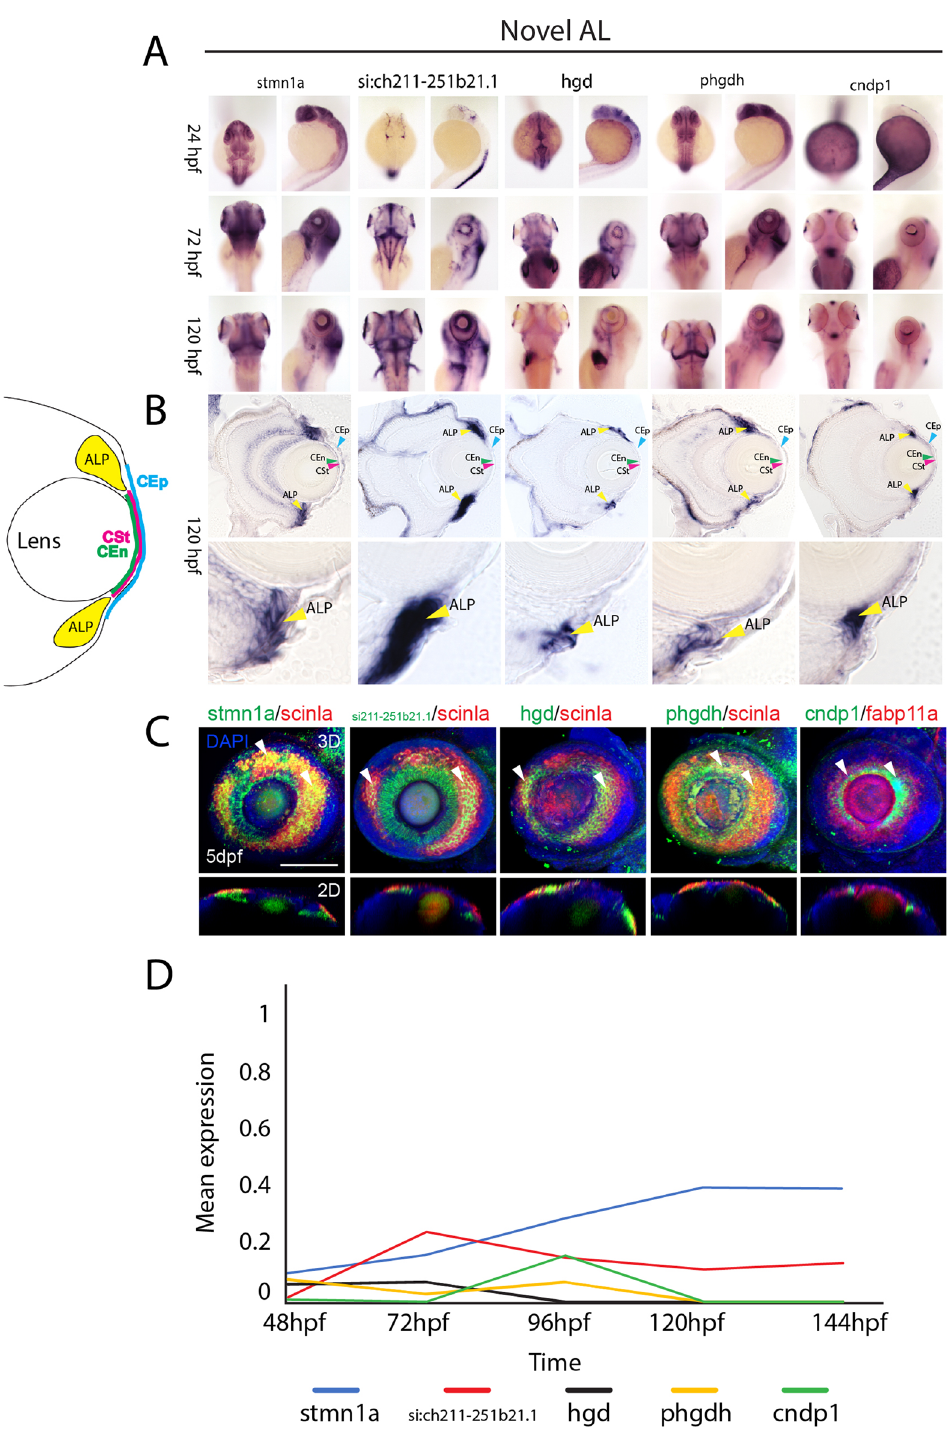
Figure 9. Expression patterns of novel annular ligament associated genes. ( A ) WISH expression analysis of annular ligament associated genes stmn1a, si:211-251b21.1, hgd, phgdh and cndp1 at 24, 72 and 120 hpf displayed in dorsal and lateral views. ( B ) 10 µm cryosections of 120 hpf embryo eyes after WISH. ( C ) Two color FWISH depicting co-expression of stmn1a (green)/ scinla (red), si:ch211-252b21.1 (green)/ scinla (red), hgd (green)/ scinla, phgdh (green)/ scinla (red) and cndp1 (green)/ scinla (red) at 120 hpf. DAPI (blue) was used to stain the nuclei. Volume projections in lateral view and single section dorsal views from 3D confocal stacks are displayed. White arrows indicate example regions of co-expression. Scale bar = 100 µm. Individual fluorescence channels are provided in Fig. S11C. ( D ) Average mean expression measurements over developmental time. ALP Annular ligament progenitor (yellow arrow), CEp Corneal epithelium (blue arrow), CEn Corneal endothelium (green arrow), CSt Corneal stroma (green